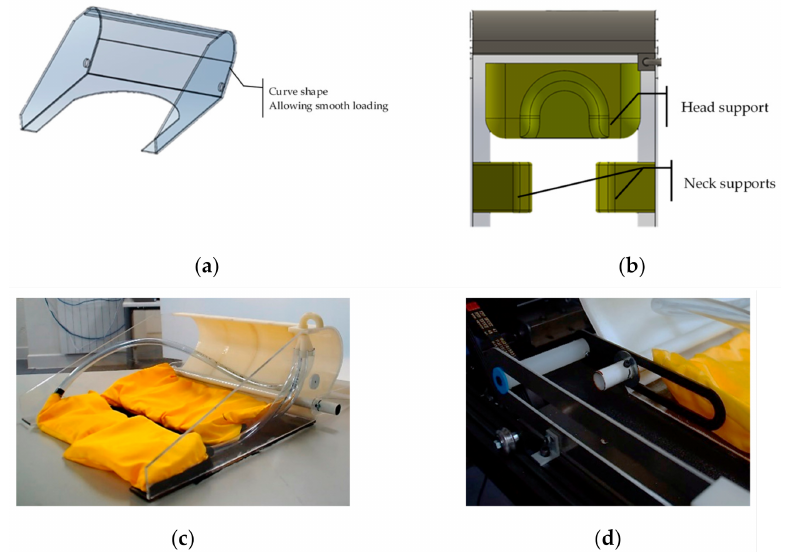
Figure 12. Design of the NSD module. The NSD module features three main components: An NSD frame, inflatable components, and a sliding guide mechanism. ( a ) The design has a curved shape to enable smooth loading up and down during the operation. ( b ) Design of the NSD inflatable components that support the casualty’s head and neck during the extraction procedure. ( c ) The NSD module. ( d ) The NSD sliding rail mechanism that allows it to slide up and down along the stretcher bed